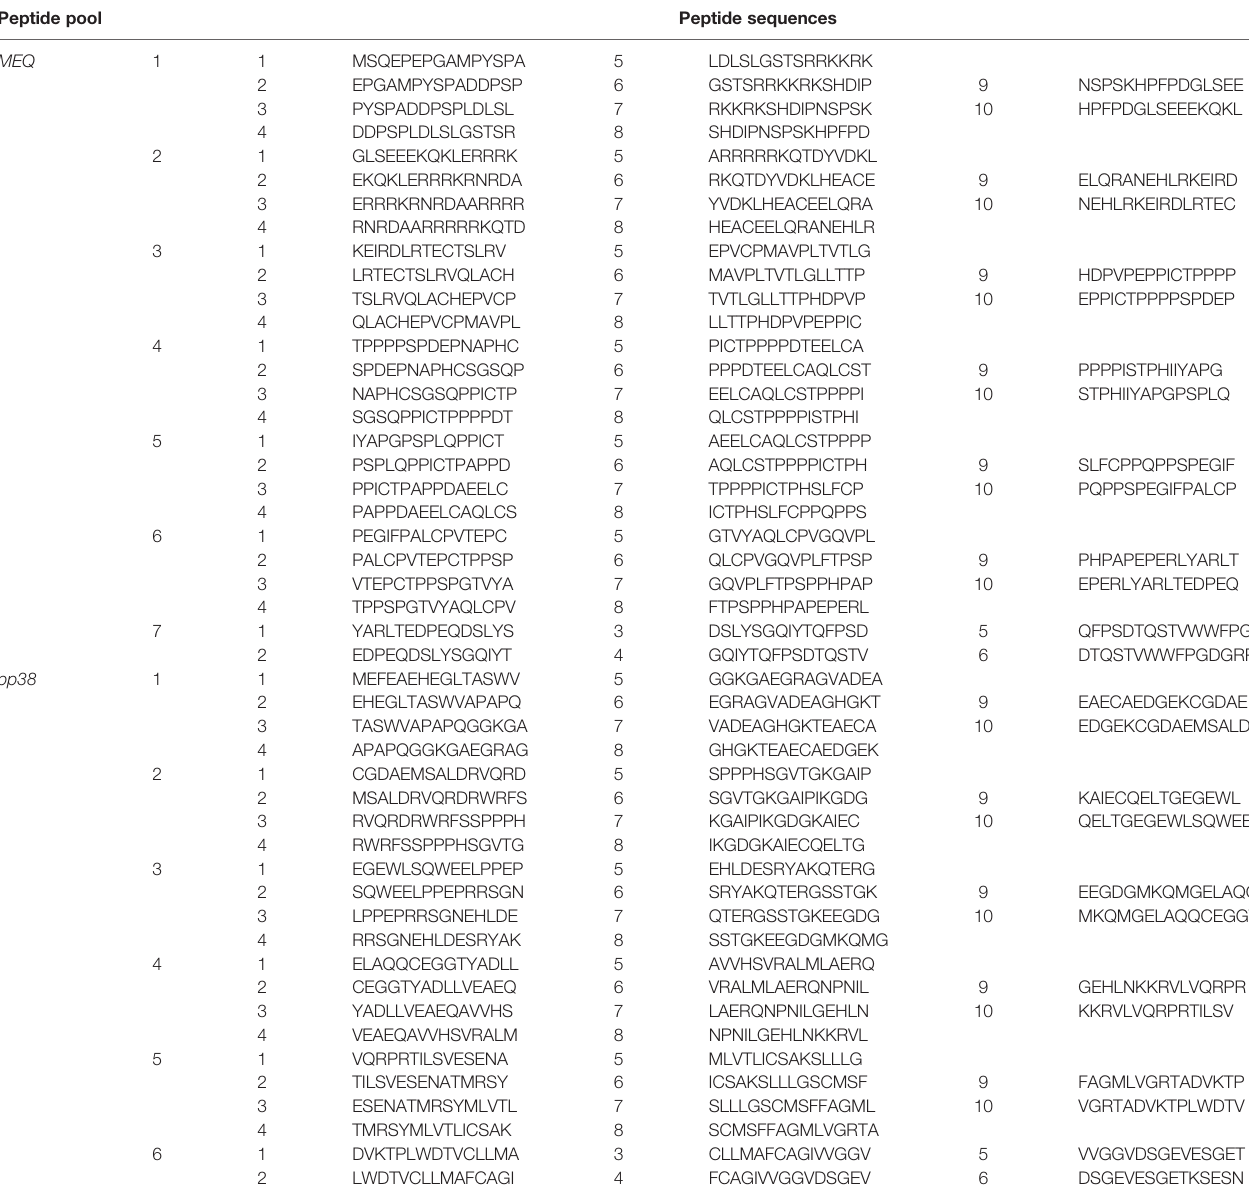
TABLE 1 | 15 mer. with 5 overlapping MDV MEQ and pp38 peptide pools. Peptide pool Peptide sequences